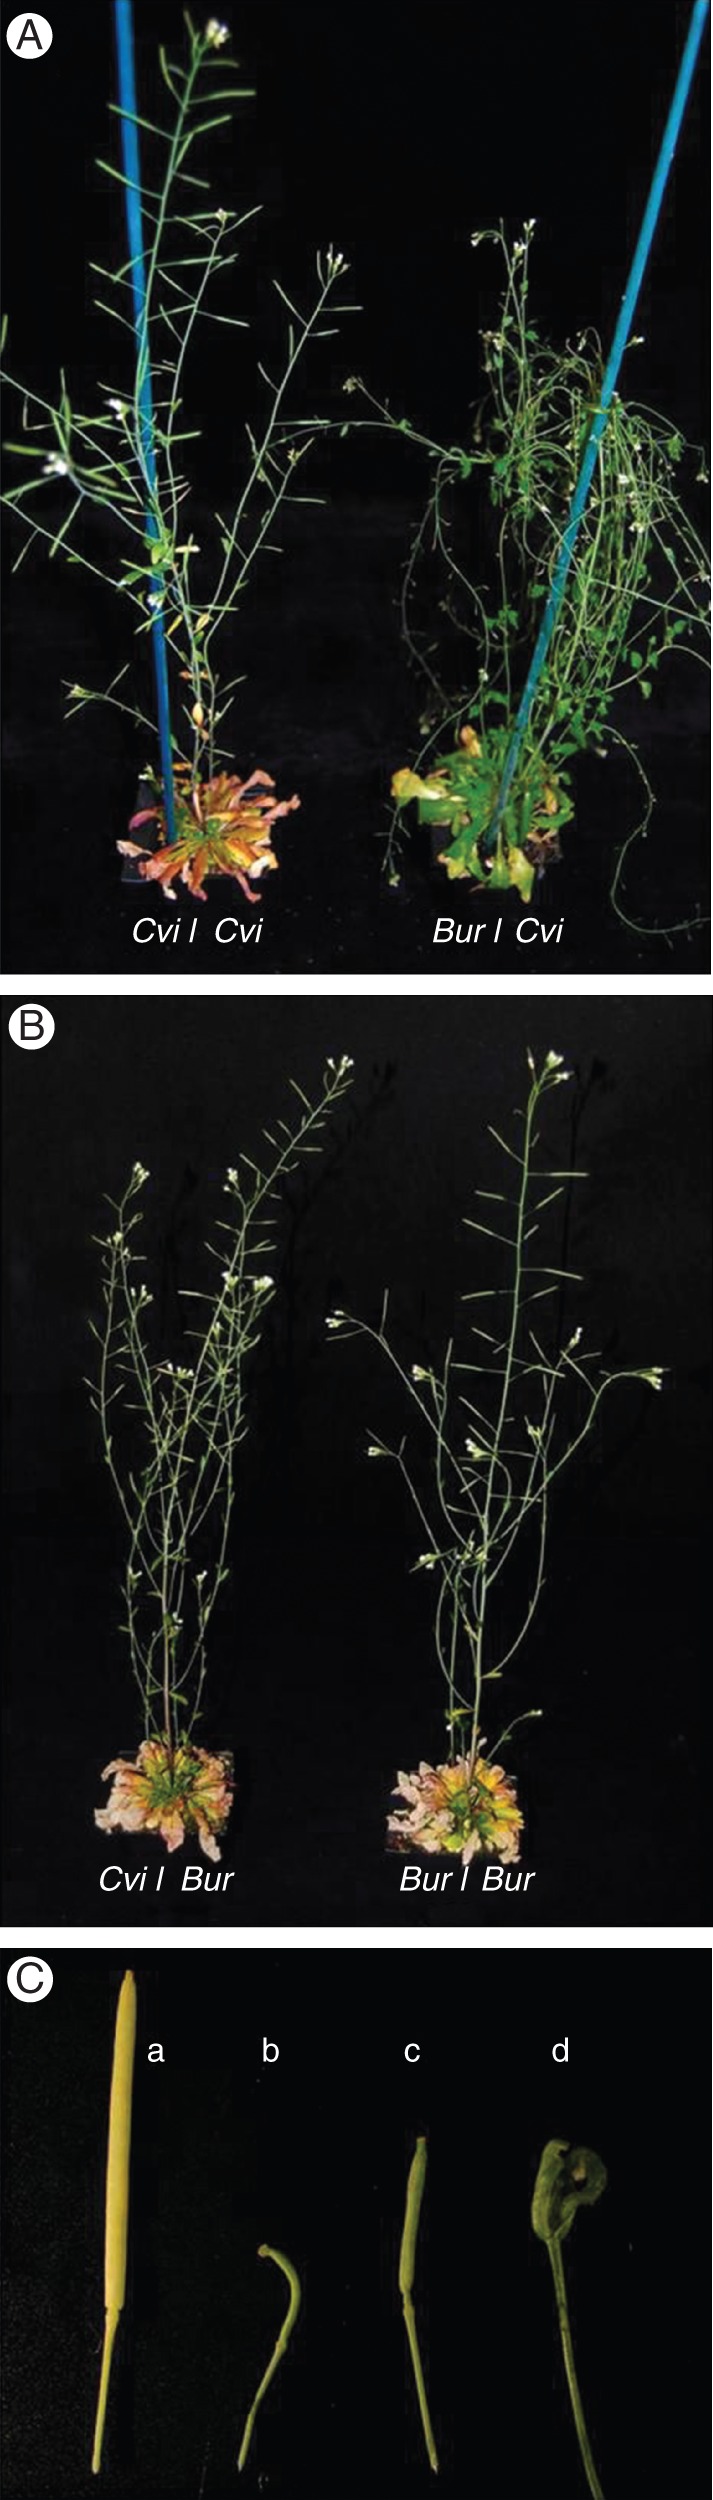
Plant phenotypes during reproductive growth. (A) Cvi and Bur plants grown in the Cvi environment; (B) Cvi and Bur plants grown in the Bur environment; (C) siliques of Bur plants developed in the Cvi environment (a, well-developed silique; b–d, curly and withered siliques).